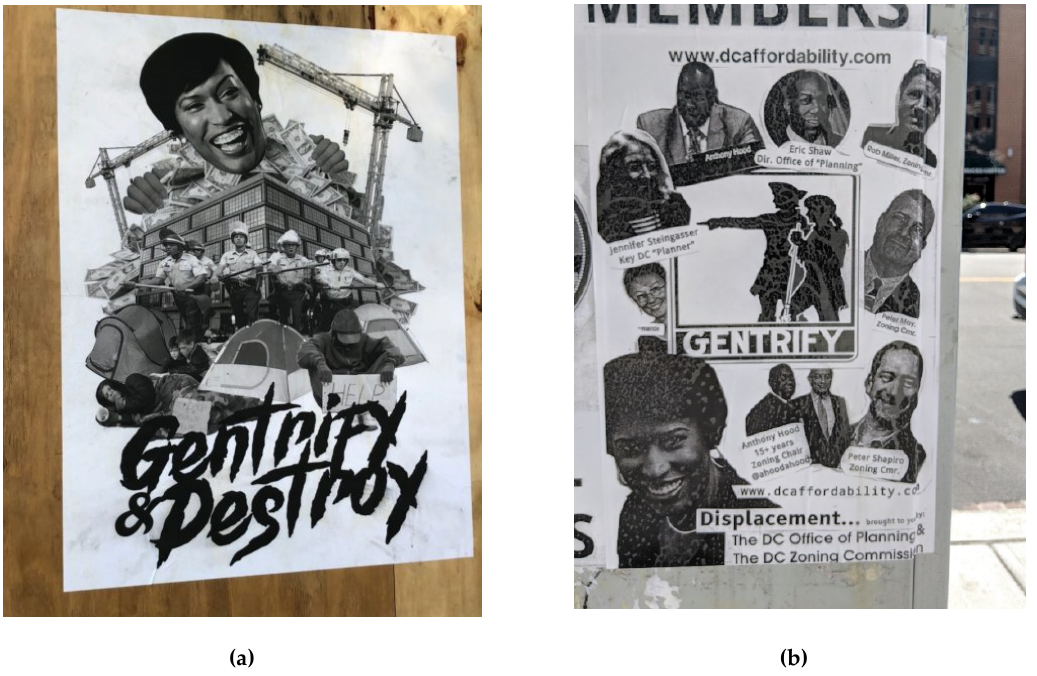
Figure 5. Posters distributed around DC in advance of the June 2018 primary elections reflect the heated public discourse around housing in Washington. ( a ) Anonymous wheatpaste flyer critiquing DC mayor. Source: [41]; ( b ) Anonymous wheatpaste flyer critiquing DC planning and zoning officials.